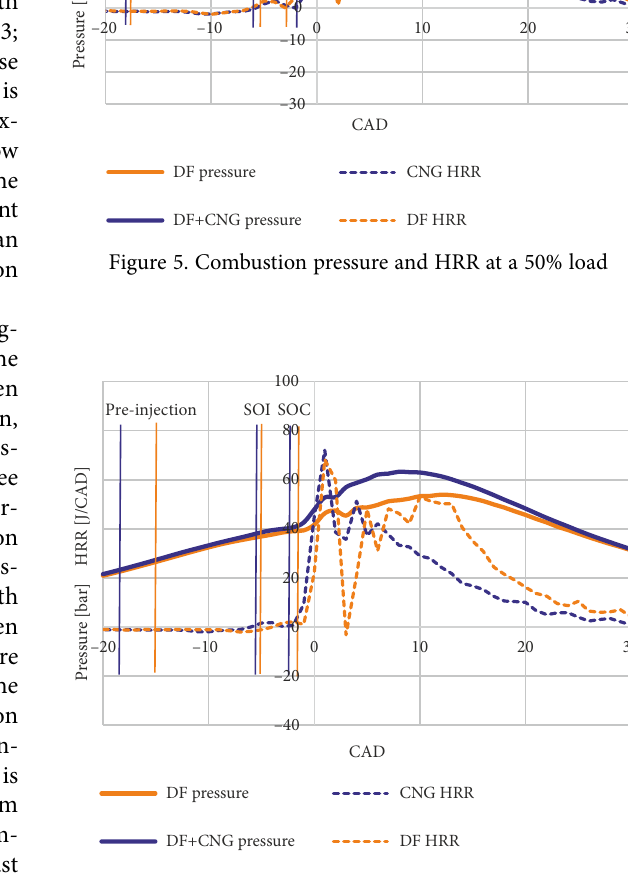
Figure 6. Combustion pressure and HRR at a 75%